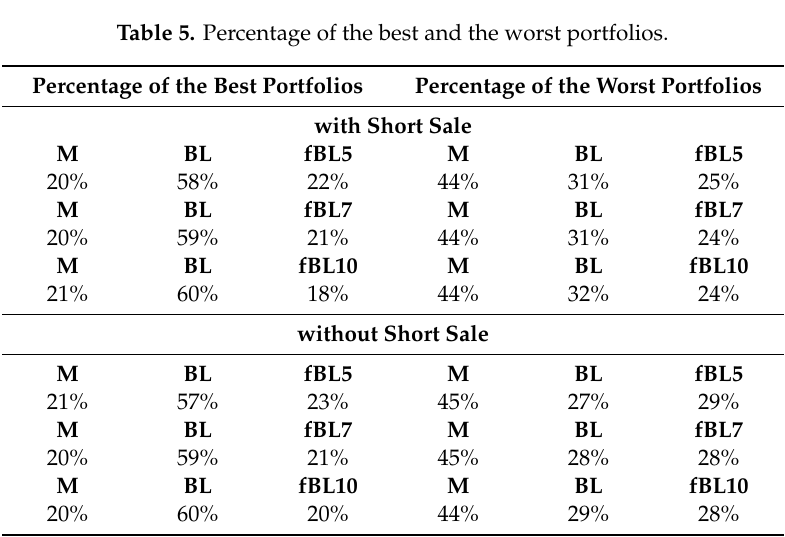
Table 5. Percentage of the best and the worst